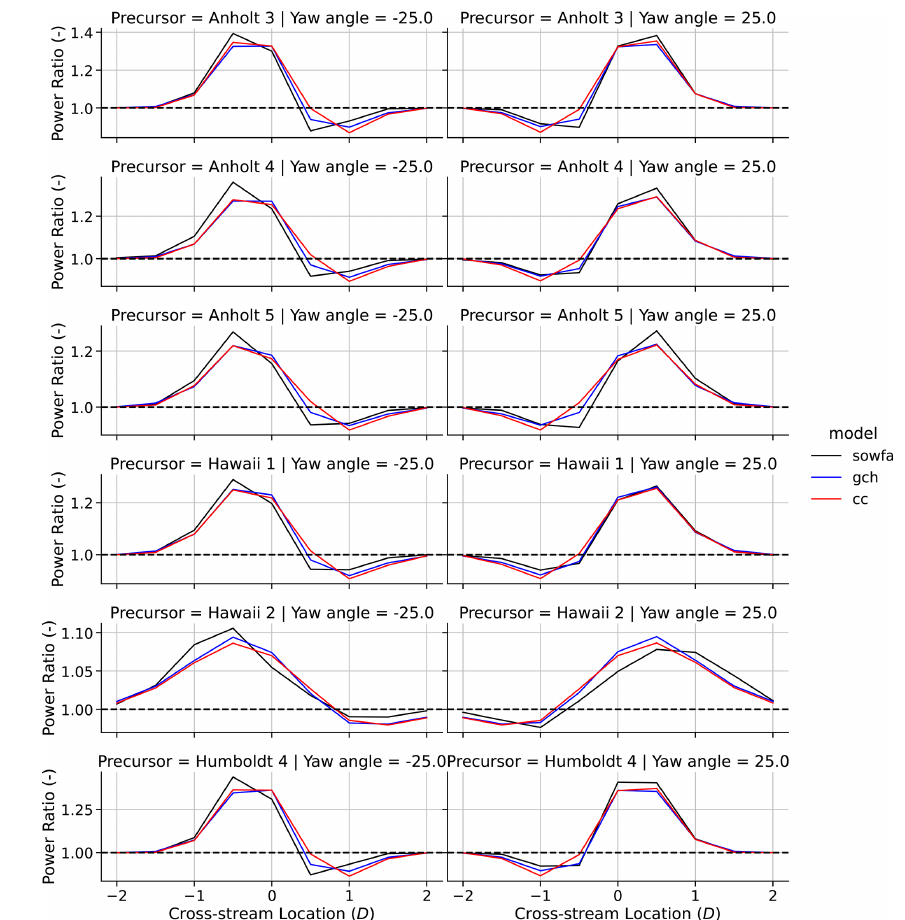
Figure 3. The power production of a hypothetical turbine distance of 7 rotor diameters from an upstream wind turbine. The upstream wind turbine is misaligned by 25 ◦ in either direction. The left column of subplots compares a − 25 ◦ (in the clockwise direction) change in yaw to the aligned case, and the right column displays a + 25 ◦ yaw misalignment (in the counterclockwise direction). The difference between the CC and GCH models for single-turbine wake steering is small, which is reassuring because the GCH model has previously shown good agreement with experimental data (Fleming et al.,